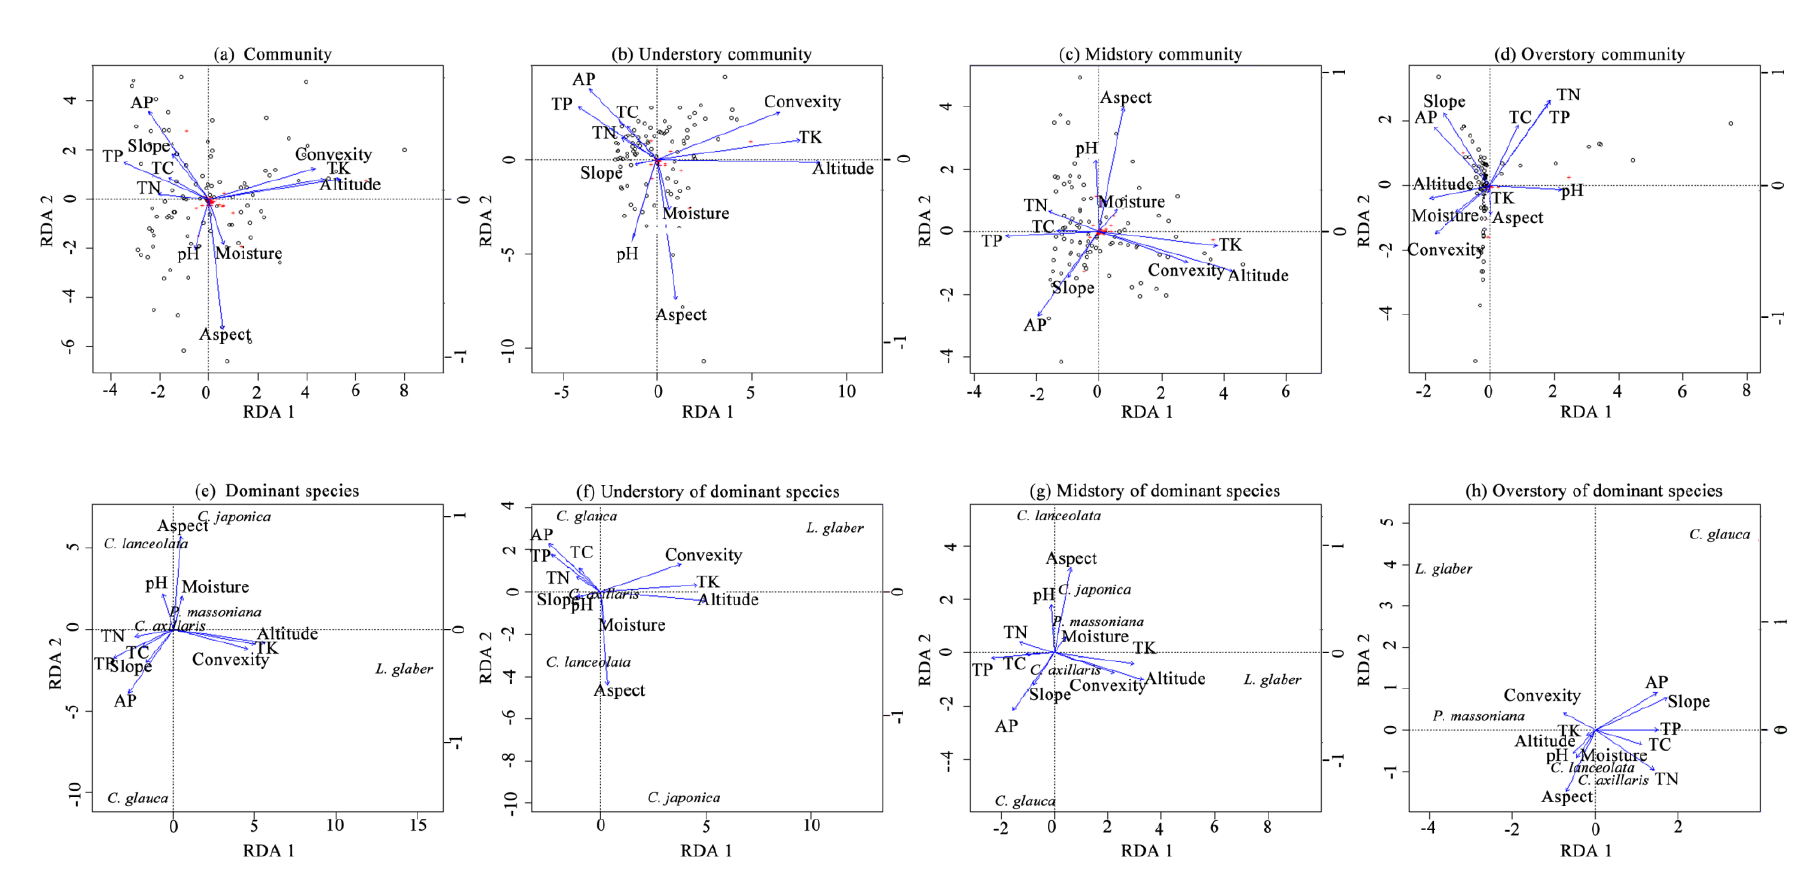
Figure 7. Canonical redundancy (RDA) plots of the whole stand and dominant species within the subtropical broadleaved forest plot on Dashanchong Forest Farm, China, displaying total layer together and each vertical layer separately. The black circle and the red crosses represent the location of subplots and species,